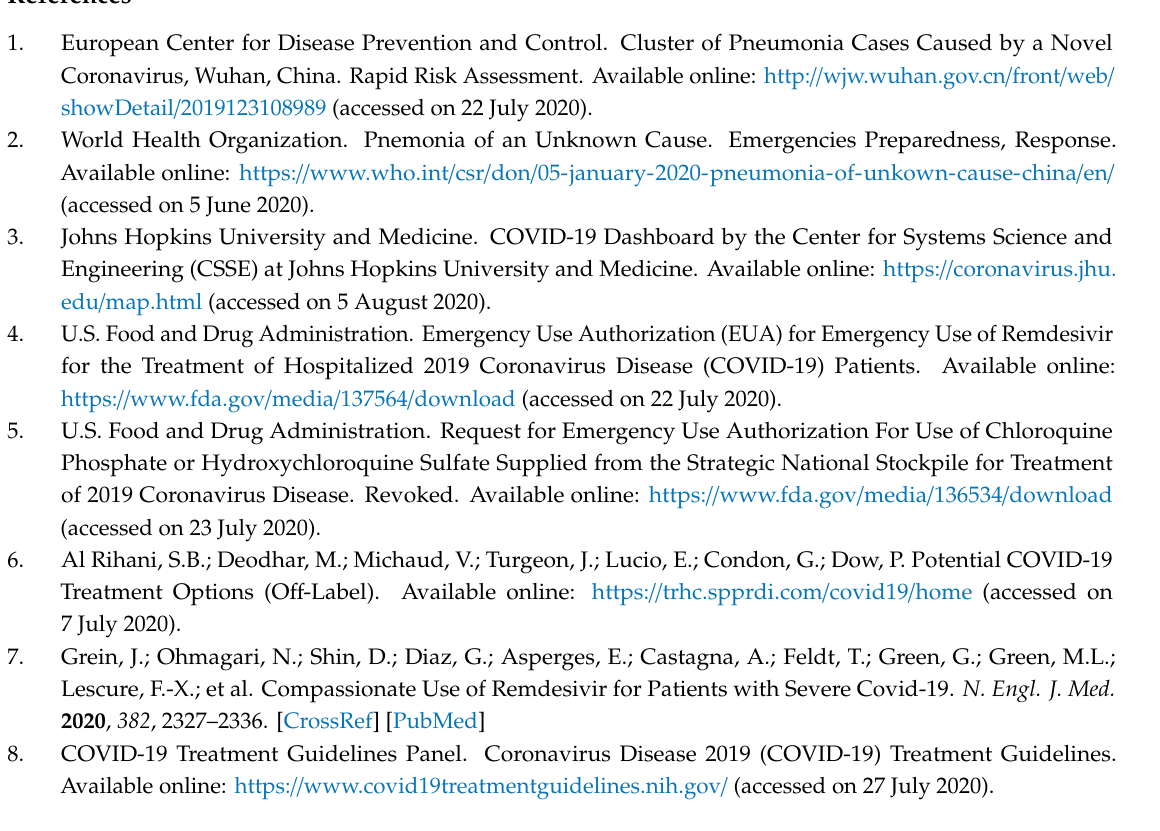
Table S1: The top 25 prescribed medications, Table S2: The most common diseases, Table S3: Concomitant CYP2C8-interacting drugs including CYP2C8 inhibitors, CYP2C8 inducers, and potential interacting CYP2C8 competitive substrates with HCQ or CQ, Table S4: The medication risk factor scores for each factor for the population under study at baseline and following the addition of COVID-19 repurposed